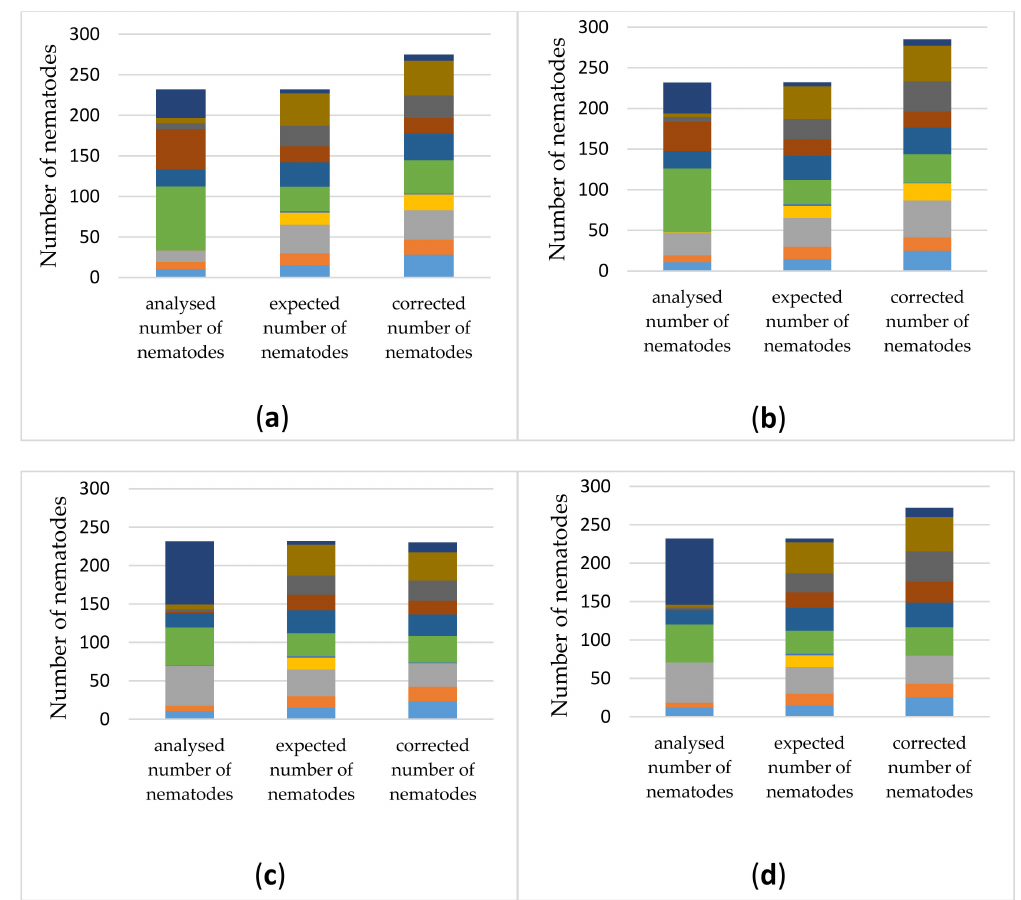
Figure 4. Number of nematodes (first column, analyzed number; second column, expected number; third column, corrected number based on the calculated correction factors from the corresponding M20 samples). ( a ) DNA-extraction based on the adapted Holterman method and NemFopt and 18Sr2bRopt primer set; ( b ) DNA-extraction based on the adapted Holterman method and EcoF and EcoR primer set; ( c ) DNA-extraction based on the Qiagen method and NemFopt and 18Sr2bRopt primer set; ( d ) DNA-extraction based on the Qiagen method and EcoF and EcoR primer set. Information about the color scales can be found in Supplementary File S4, tab